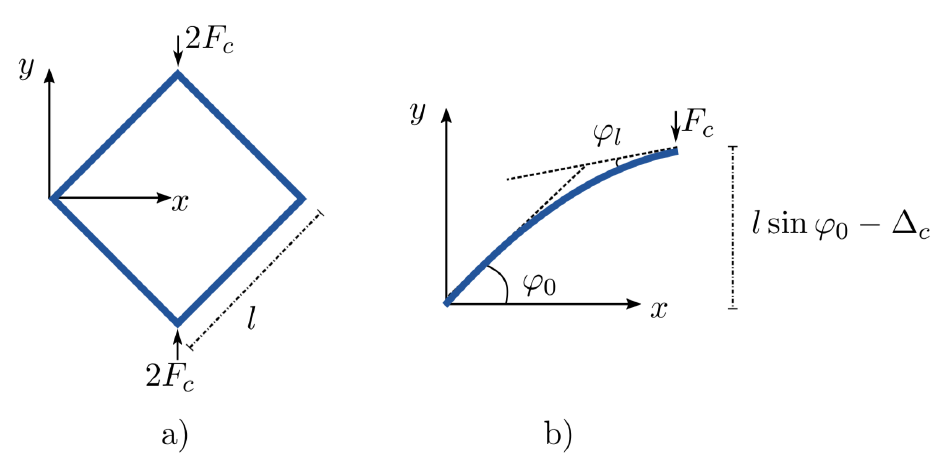
Figure 5. ( a ) Square shaped microcell subject to combined bending and compression, ( b ) free body diagram of a single microcell wall (beam) subject to large deflection.